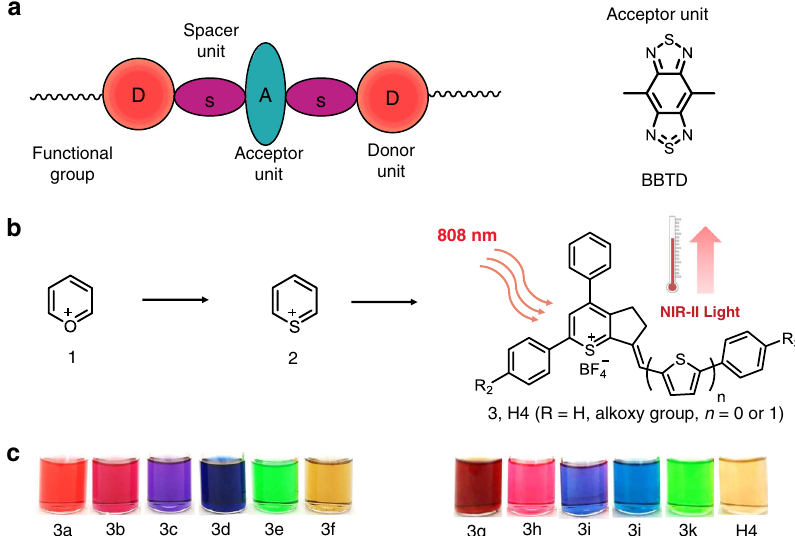
Fig. 1 Structural design and bright- fi led images of 3a – 3k, H4. a Traditional NIR-II small-molecule dyes based on the BBTD core with D – A – D or symmetrical structures. b A new strategy for the construction of D – A type thiopyrylium mitochondria-targeted NIR-II dyes with FUCL and photothermal properties, n = 0, 1. c Bright fi eld images of a series of new thiopyrylium-based probes 3a – 3k and H4 in